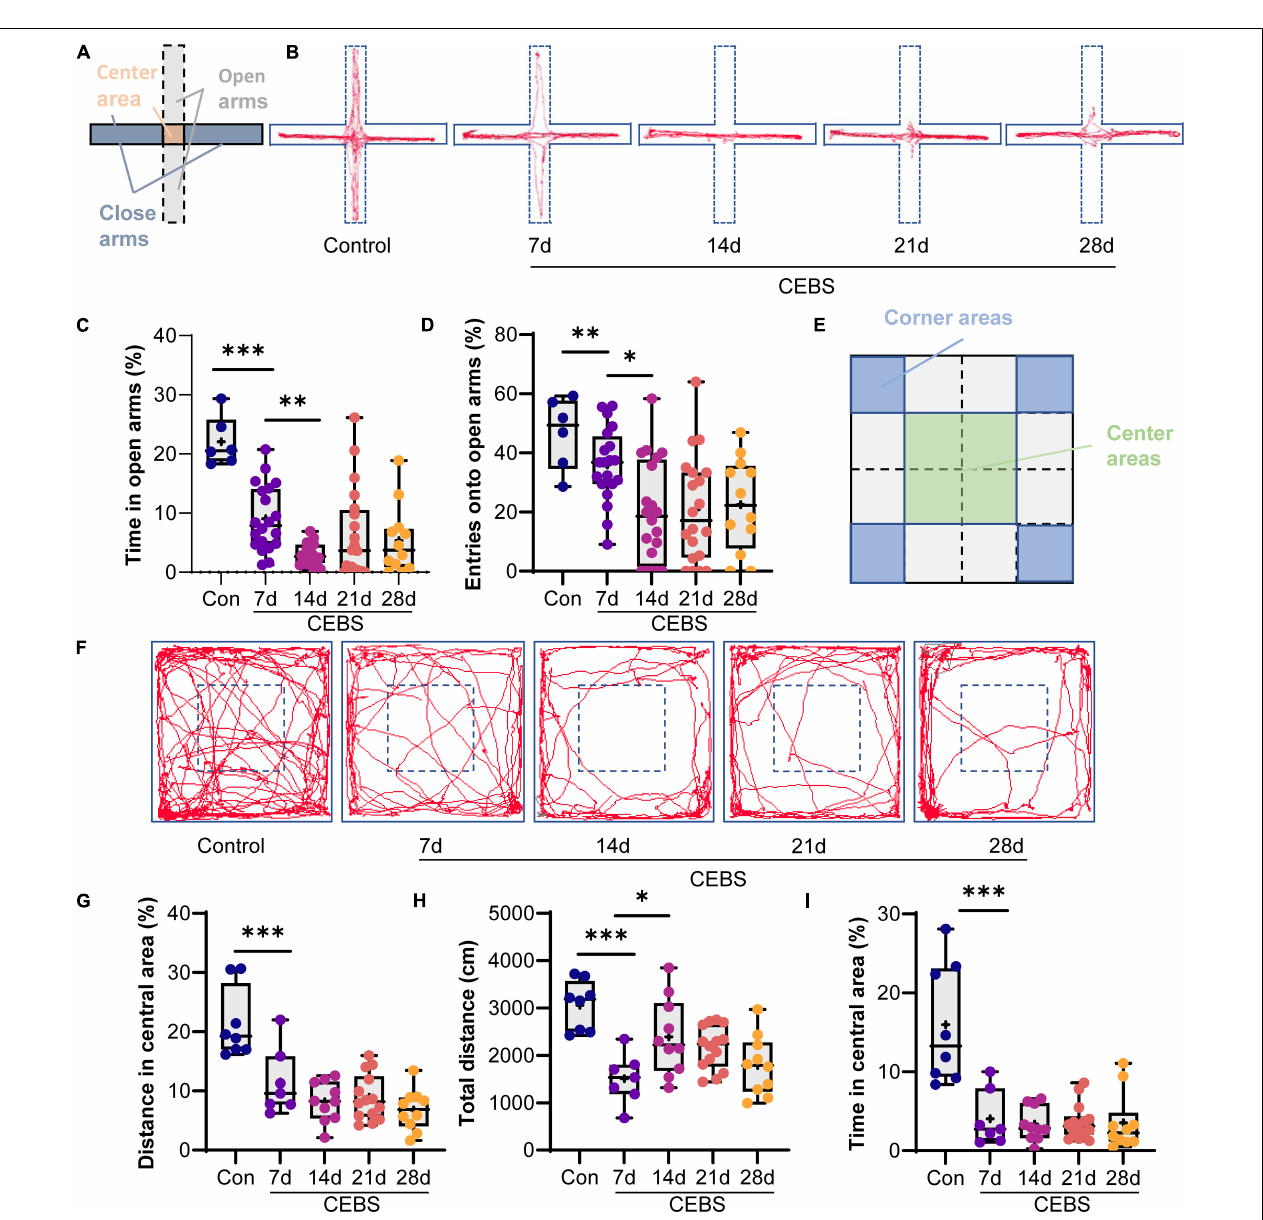
FIGURE 2 | EPM and OF tests showed that the anxiety-like behavior of the CEBS mice had dynamic change. Schematic diagram of EPM (A) and OFT (E) . Different groups of EPM test motion trajectory diagrams (B) . Time in open arms (C) and entry onto open arm times (D) in the EPM. Different groups of OF test motion trajectory diagram (F) . The distance (G) and time (I) in the center area of the EPM test, the total distance (H) in the OFT. Data are presented as mean ± SEM or median (Interquartile range, IQR) from n = 6–8 mice/control group, n = 20 mice/CEBS group (C,D) , and n = 7–15 mice/CEBS group (G–I) , ∗ P < 0.05, ∗∗ P < 0.01, and ∗∗∗ P <